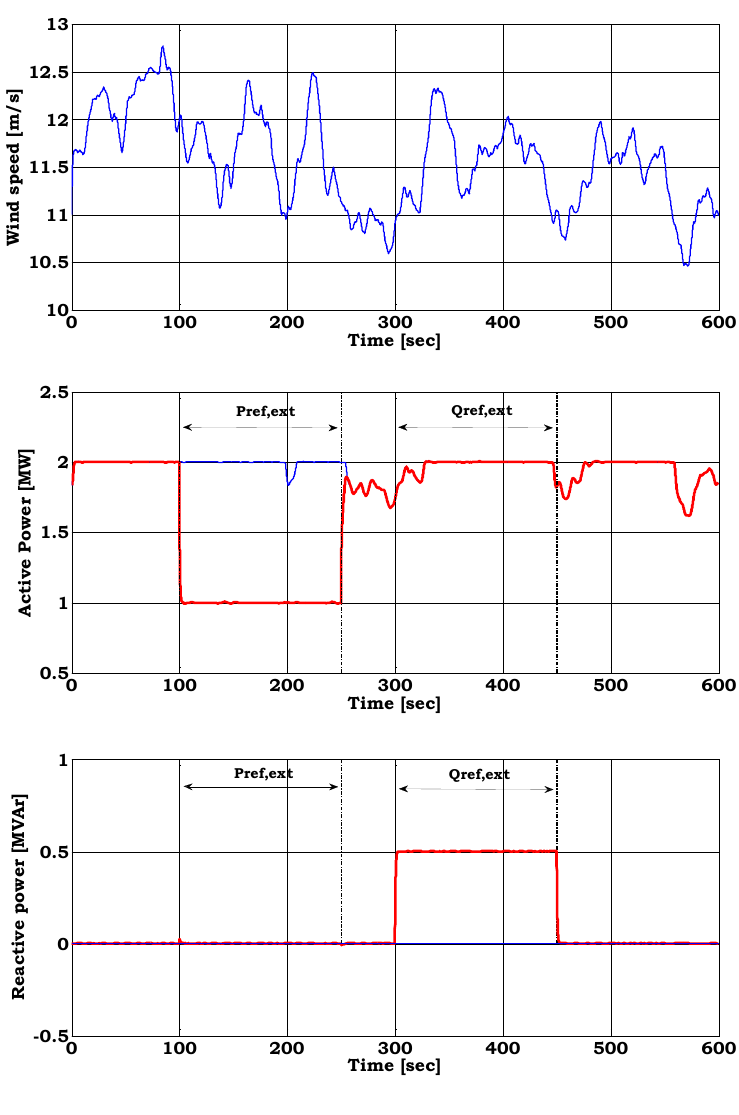
Figure 3. Stochastic wind speed, active power and reactive power during normal operation with (red line) and without (blue line) imposed reference